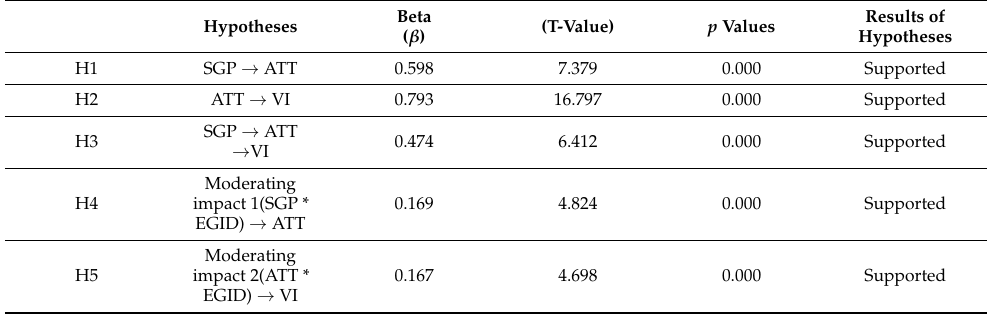
Table 5. The structural inner model’s